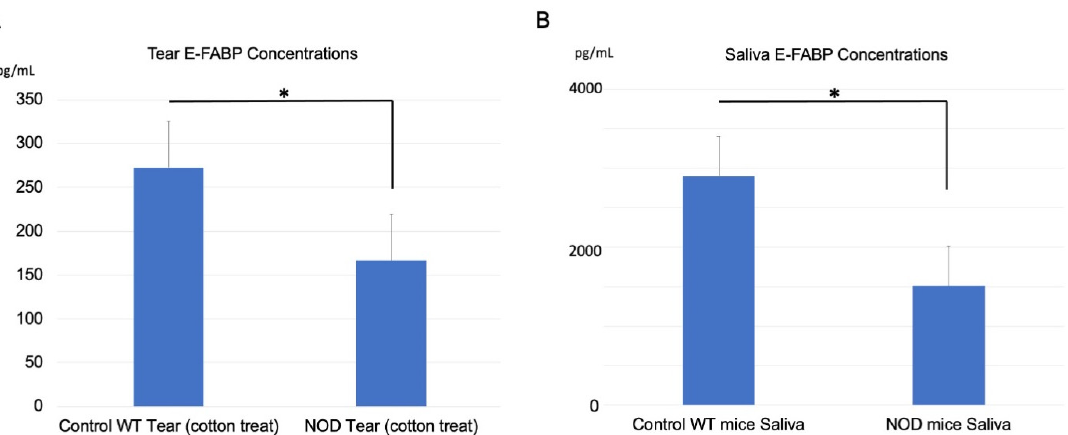
Figure 3. Comparison of E-FABP concentrations in tears and saliva between the wild-type (WT) mice and the NOD mice. ( A ) Tear E-FABP concentration in the NOD mice was significantly lower than in the WT mice. ( p = 0.0135). ( B ) Saliva E-FABP concentration in the NOD mice was also significantly lower than in the WT mice. ( p = 0.04). * represents p < 0.05. E-FABP: epidermal fatty acid binding protein.